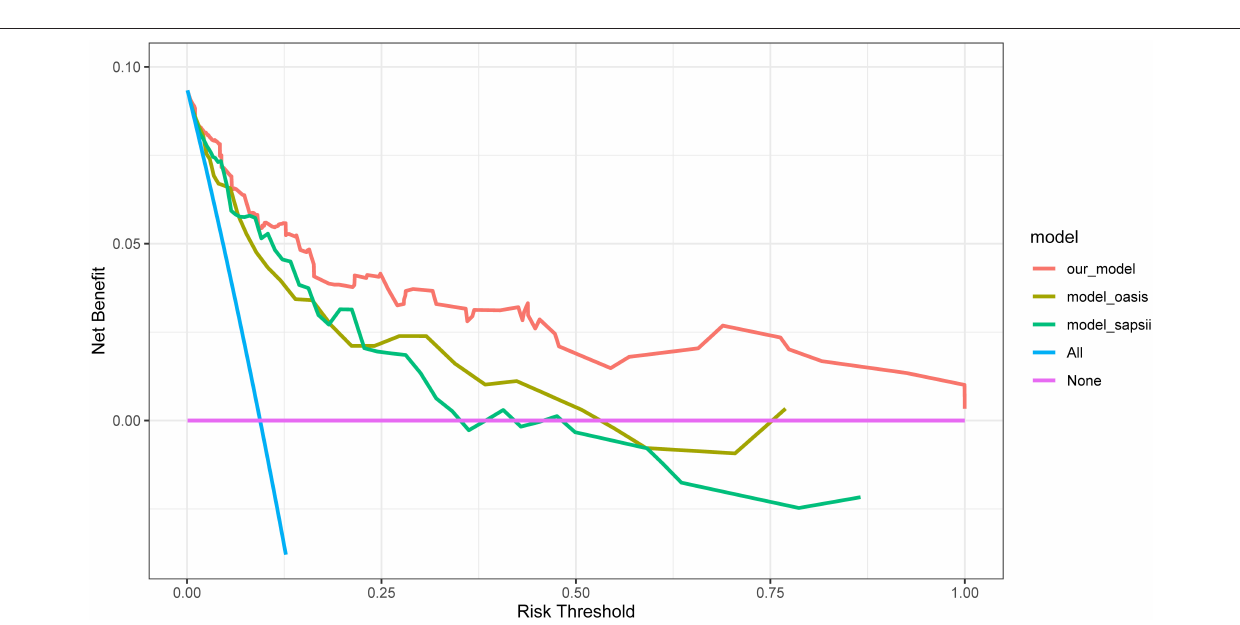
FIGURE 6 | DCA for our model, OASIS and SAPS II. The y-axis measures the net benefit. DCA, decision curve analysis; OASIS, oxford acute severity of illness score; SAPS II, simplified acute physiology score